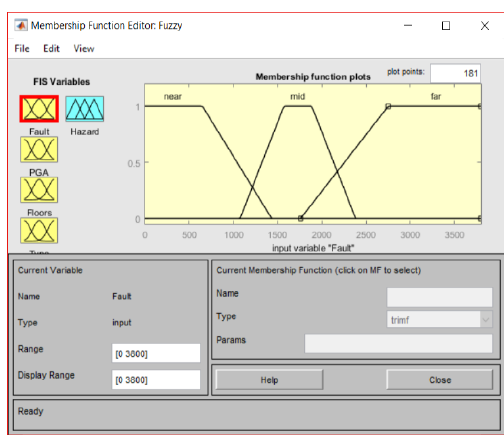
Figure 6. Fault distance membership functions